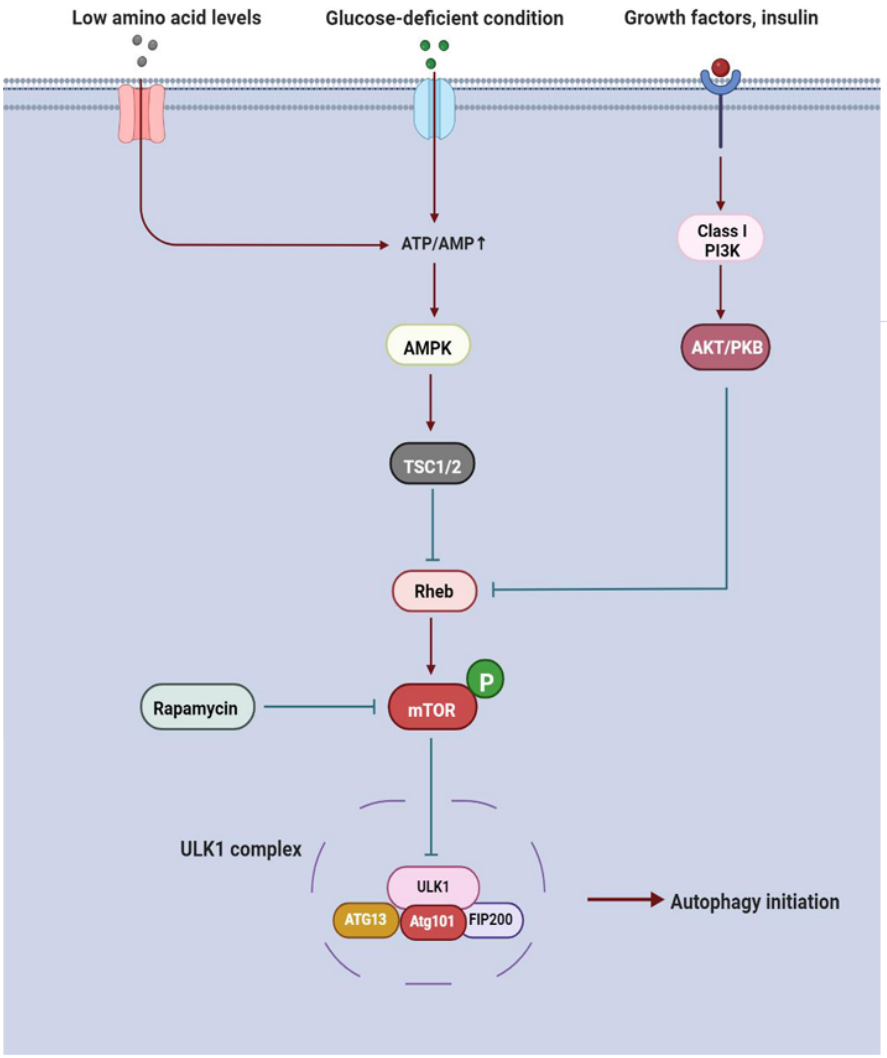
Figure 3. Overview of upstream signaling pathways that regulate macroautophagy. Autophagy induction is initiated when mTOR signaling is suppressed by a range of stress modalities and an upstream signaling cascade. Abbreviations: PKB, protein kinase B; AMPK, AMP-activated protein kinase; TSC1, tuberous sclerosis complex 2; TSC2, tuberous sclerosis complex 2; mTOR, mammalian target of rapamycin.